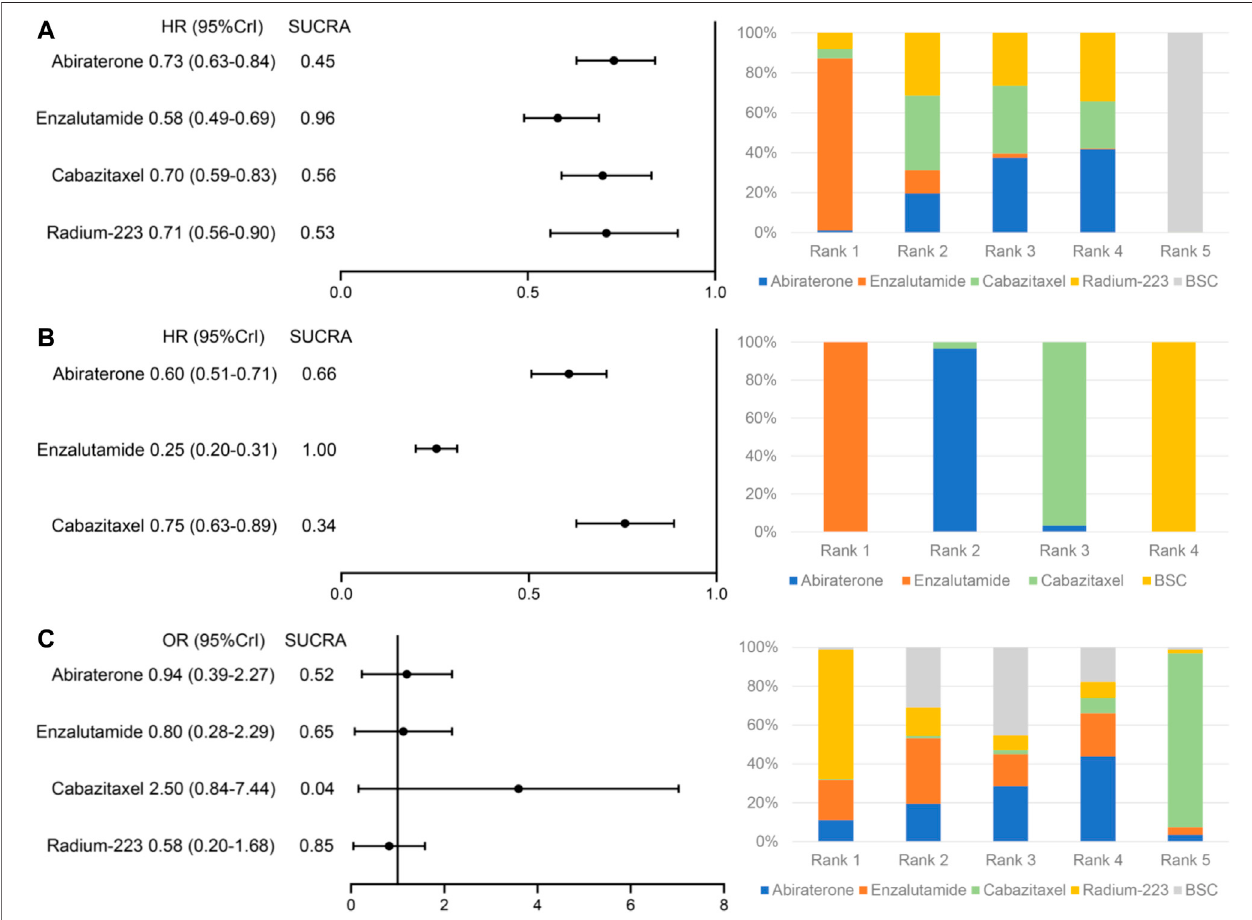
FIGURE 3 | Relative effects of systemic treatments compared to best supportive care and treatment ranking on (A) overall survival, (B) biochemical progression- free survival, and (C) serious adverse events.